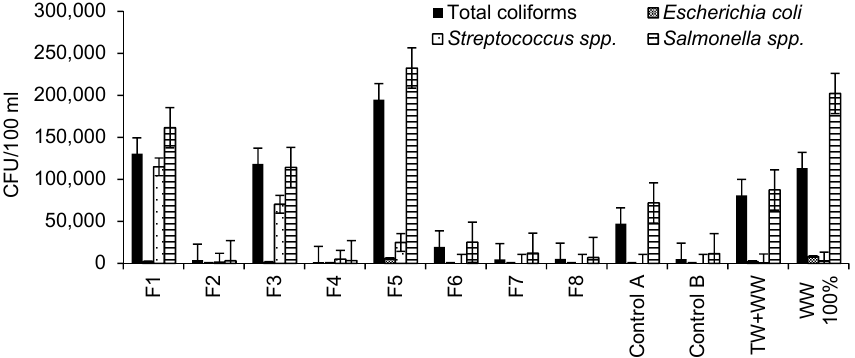
Figure 2. Microbiological characteristics of irrigation water (sample number: 20; 11 October 2013 to 25 September 2014).